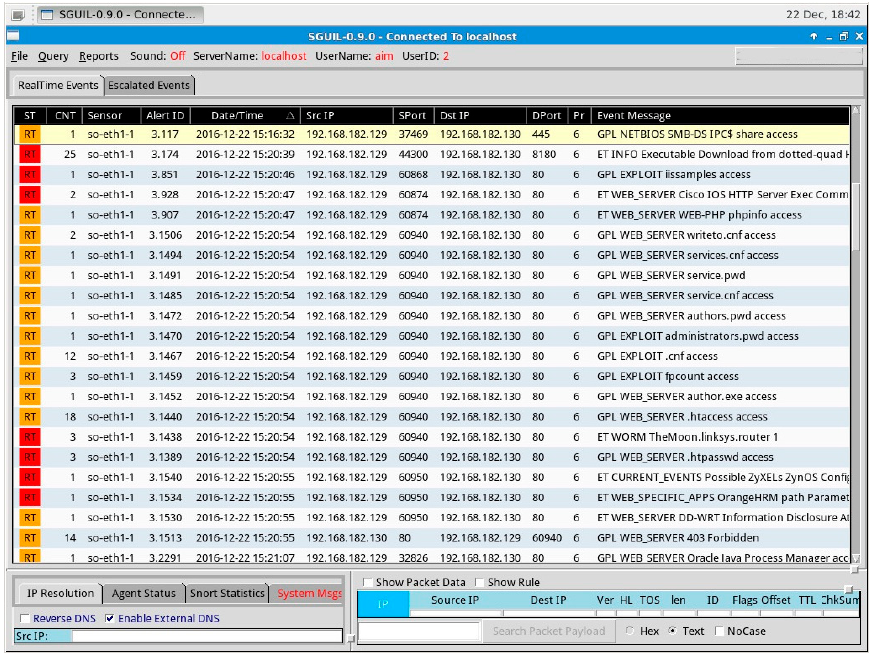
Figure 5. Sguil Console Output: Enumeration Phase.